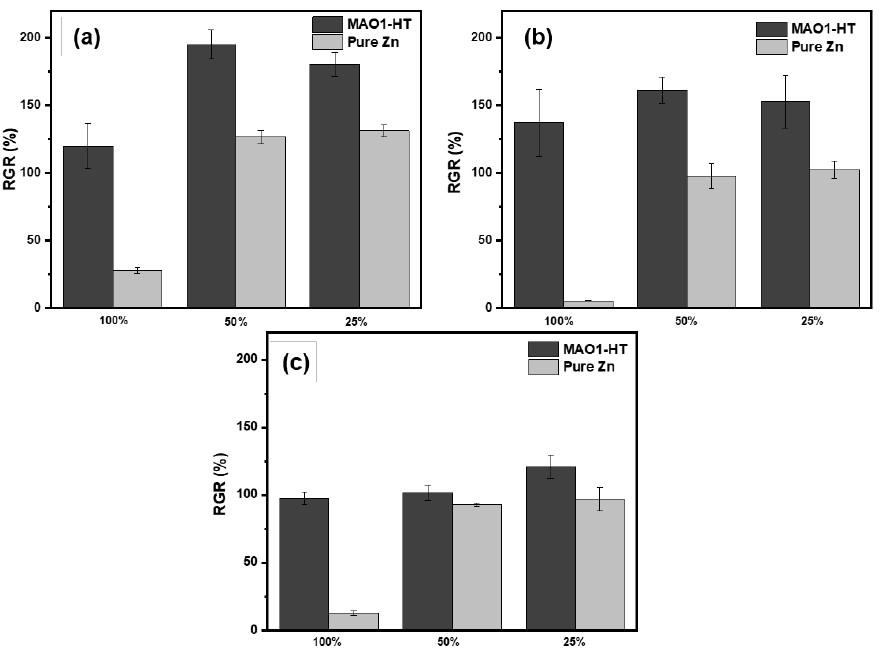
Figure 6. MTT results of L929 cells in pure Zn and MAO1−HT coating leach liquor for ( a ) 1 day, ( b ) 2 days, and ( c ) 3 days. ( b ) 2 days, and ( c ) 3 days.